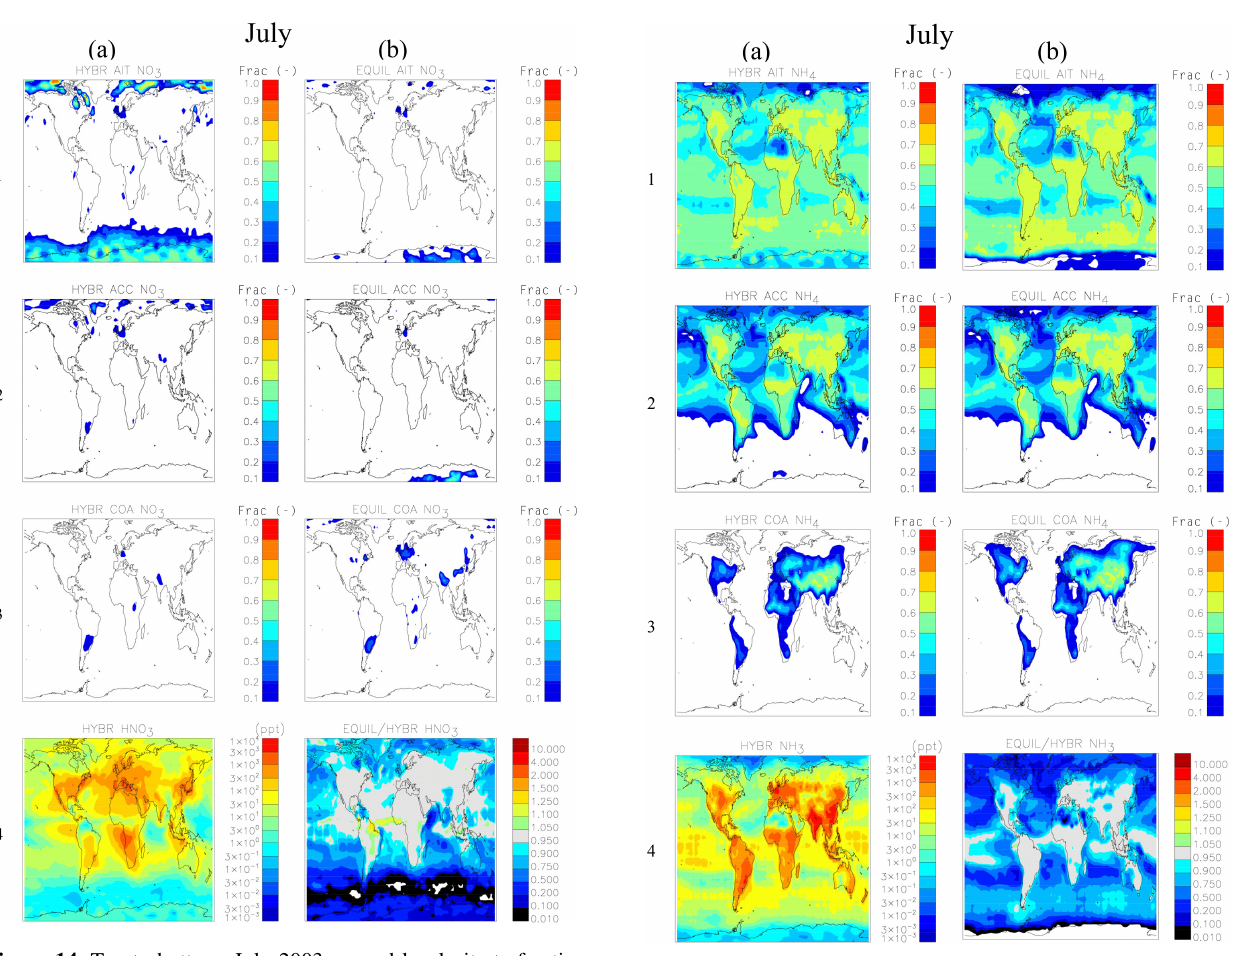
Figure 15. Same as Fig. 14 for ammonium (1–3) and ammonia